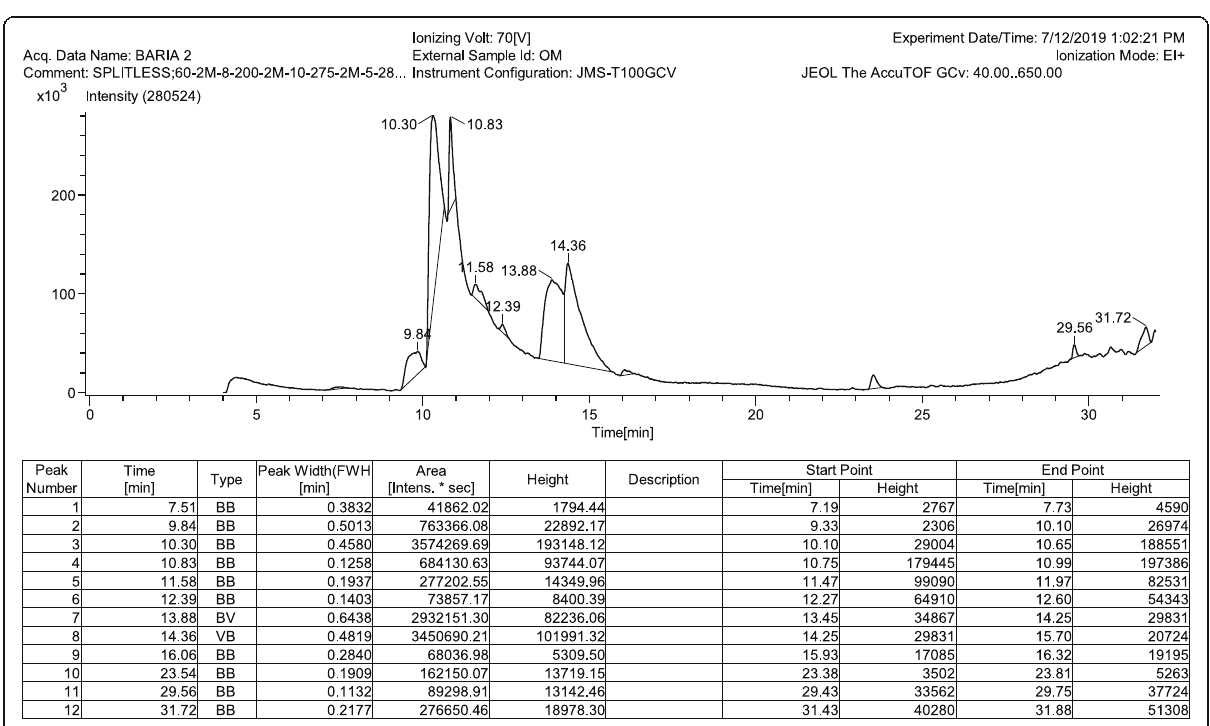
Fig. 2 GCMS chromatogram of methanol extract of fermented Allium cepa peels